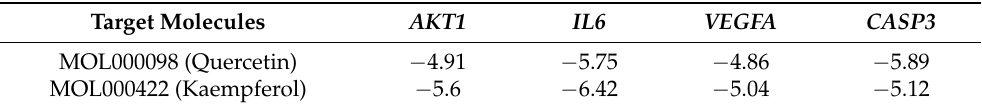
Figure 7. Molecular docking of quercetin and kaempferol with AKT1, IL6, VEGFA and CASP3. ( A ) Quercetin and AKT1 . ( B ) Quercetin and IL6 . ( C ) Quercetin and VEGFA . ( D ) Quercetin and CASP3 . ( E ) Kaempferol and AKT1 . ( F ) Kaempferol and IL6 . ( G ) Kaempferol and VEGFA . ( H ) Kaempferol and CASP3 . Table 3. Docking and binding energy of main components of Japanese Ardisia and core targets (kcal · mol − 1